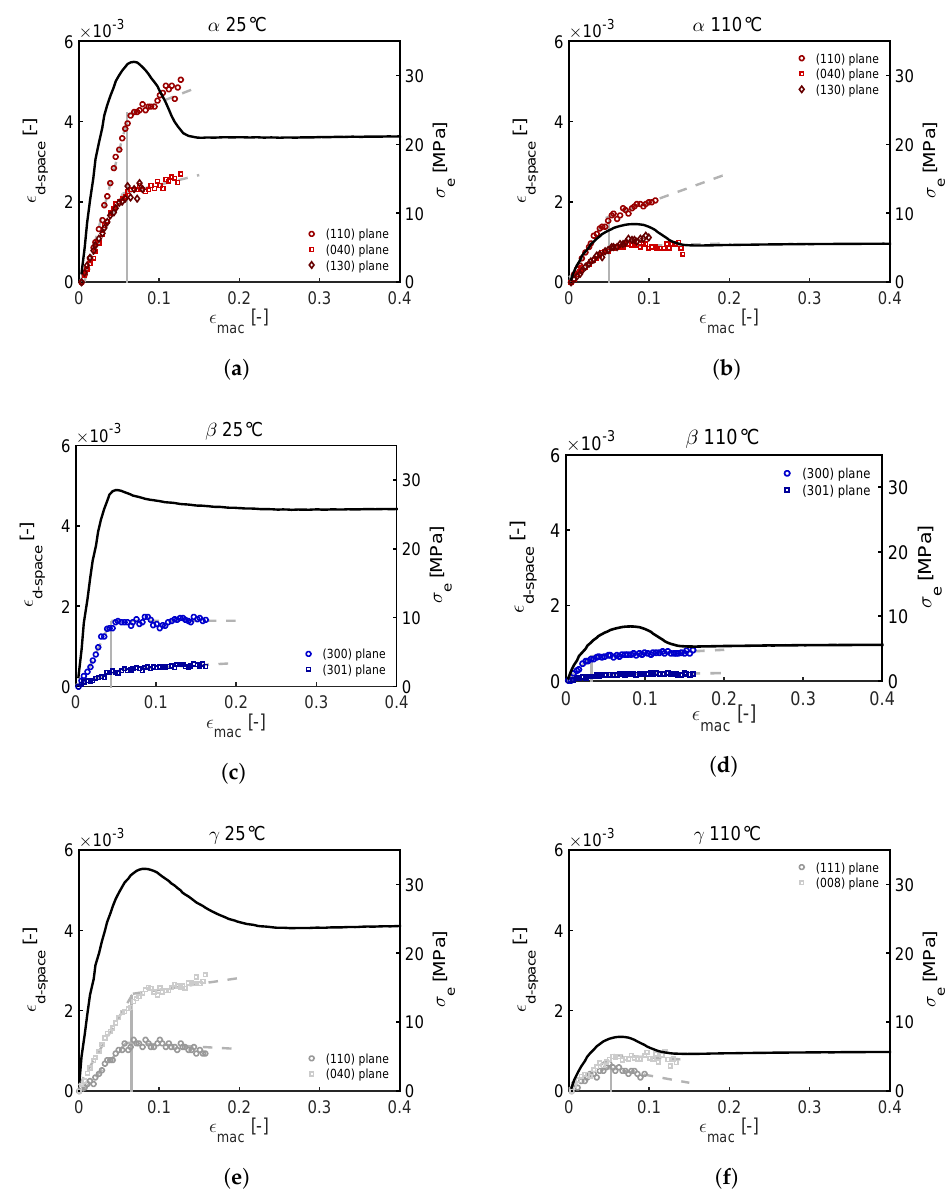
Figure 19. The increase of the distance between crystal planes of ( a , b ) α -iPP; ( c , d ) β -iPP and ( e , f ) γ -iPP. The strain at which the distance between the crystal planes no longer increases following the initial slope is associated with the onset of the plastic deformation. Figure ( a , c , e ) are obtained from tensile tests performed at 25 ◦ C, while ( b , d , f ) are taken at 110 ◦